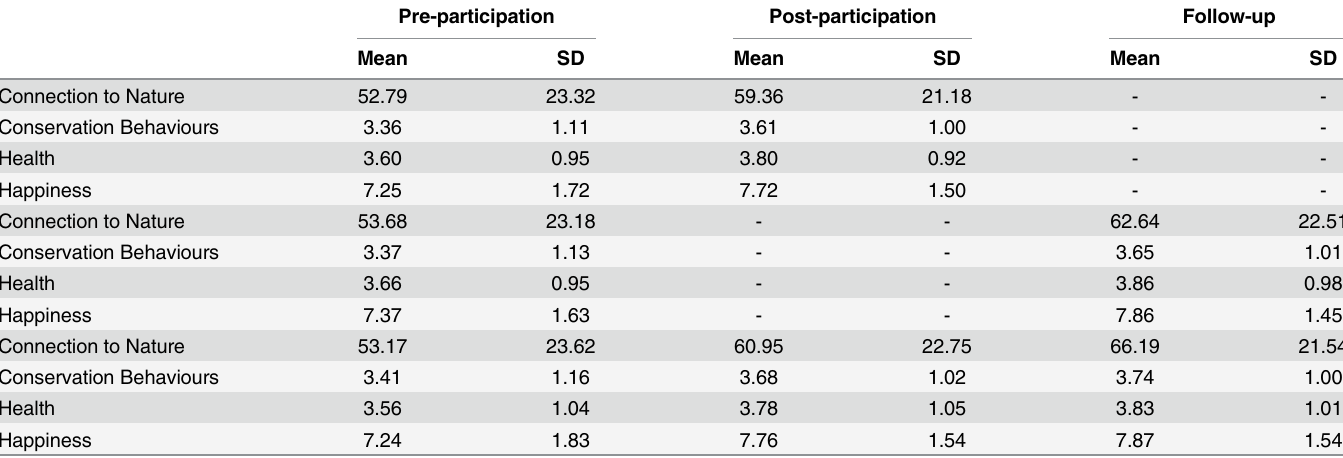
Table 2. Pre, post-participation and follow-up means and standard deviations for the four outcome measures.